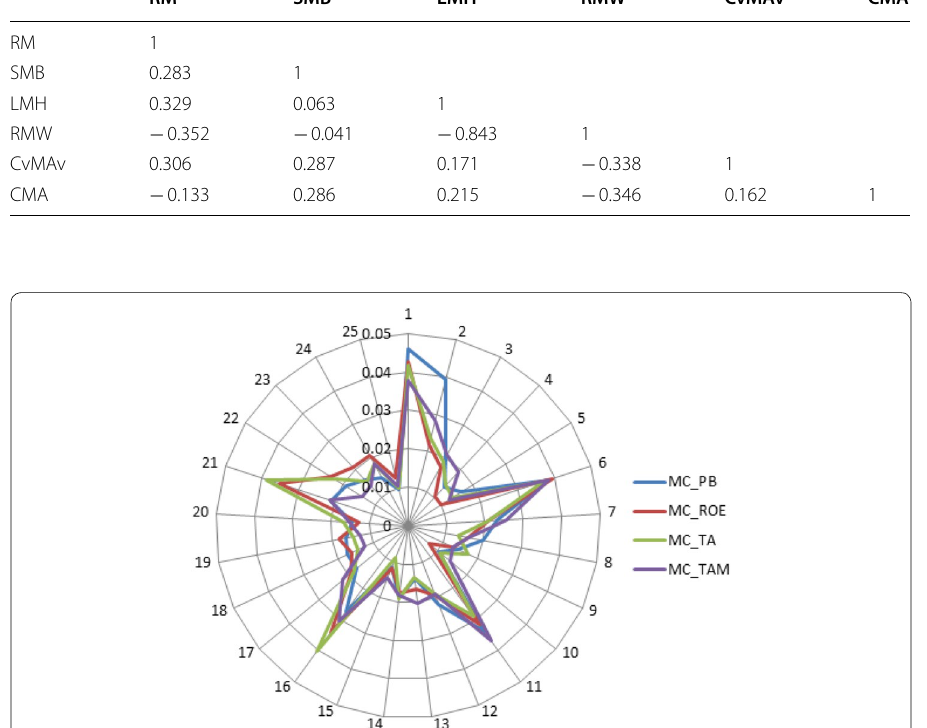
Table 2 Correlation matrix for explanatory variables RM